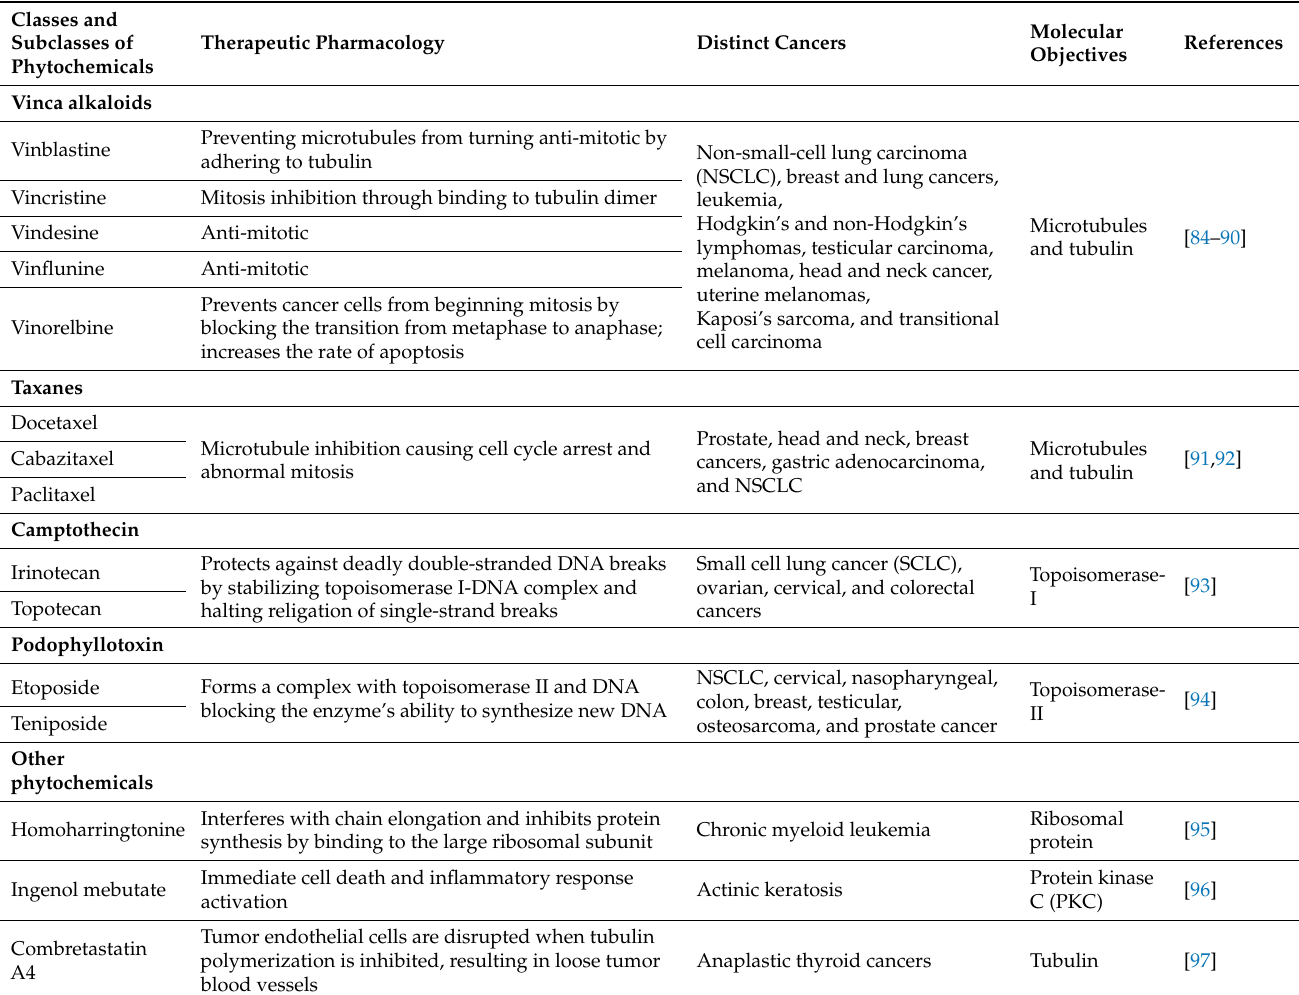
Table 1. Major classification of phytochemicals and their uses in cancer